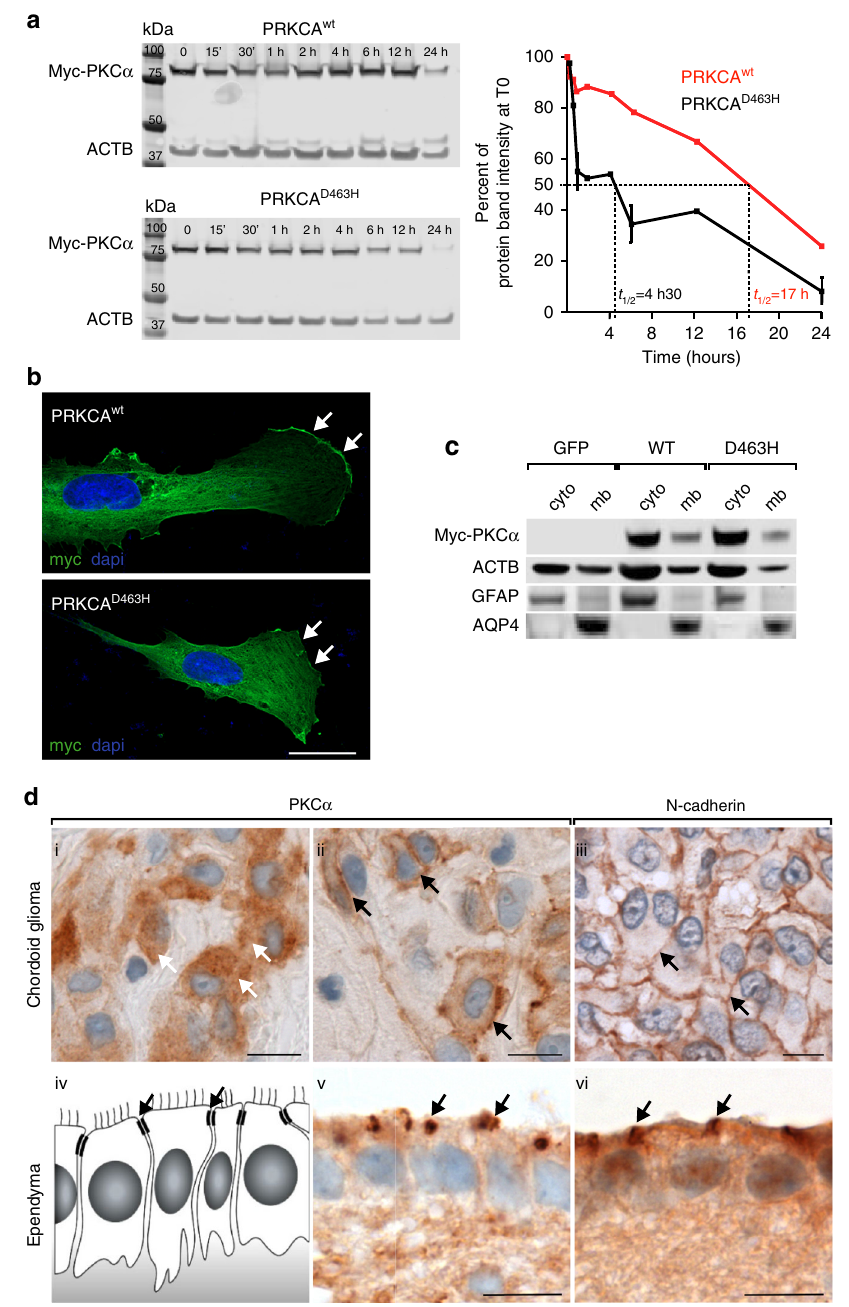
Fig. 2 Characterization of the PKC α D463H mutant protein. a PKC α D463H is less stable than PKC α WT : blockage of protein synthesis with 500 µ g/mL of cycloheximide was performed on transduced COS-7 cells (see Methods) with dosage of the recombinant protein at different times, and shows decreased half-life of D463H mutant vs. wild-type protein. b PKC α D463H mutation leads to membrane delocalization. Human immortalized astrocytes transduced with PRKCA D463H -Myc lentivirus leads to decreased Myc expression at the membrane, compared to astrocytes transduced with PRKCA WT -Myc. Scale bar = 10 microns. c Subcellular fractionation of transduced cells shows moderately decreased amount of PKC α D463H -Myc protein at the membrane, compared to PKC α WT -Myc and control GFP lentivirus (ACTB = beta-actin, AQP4 = aquaporin 4). d Expression and subcellular localization of PKC α in chordoid gliomas. Subcellular localization of PKC α (brown; panels i, ii, v) is cytoplasmic (i, white arrows), and much less frequently diffusely lining the cytoplasmic membrane (ii, black arrows), similar to N-Cadherin (iii, black arrows). In comparison, in normal ependyma, PKC α is concentrated at the zonula adherens (v, black arrow), similar to N-Cadherin (vi, black arrows). Scale bar = 10 a highly conserved Aspartic Acid in the kinase active site into activity of D463 toward the Ser/Thr substrates of PKC α an Histidine. The D463H amino acid change is predicted by (Protein data base 21 ). PRKCA is mutated in a wide range of human cancers, but three independent algorithms to harbor major functional con- PRKCA D463H has not been reported in other tumors, including sequences that are likely to be related to the key, deprotonating